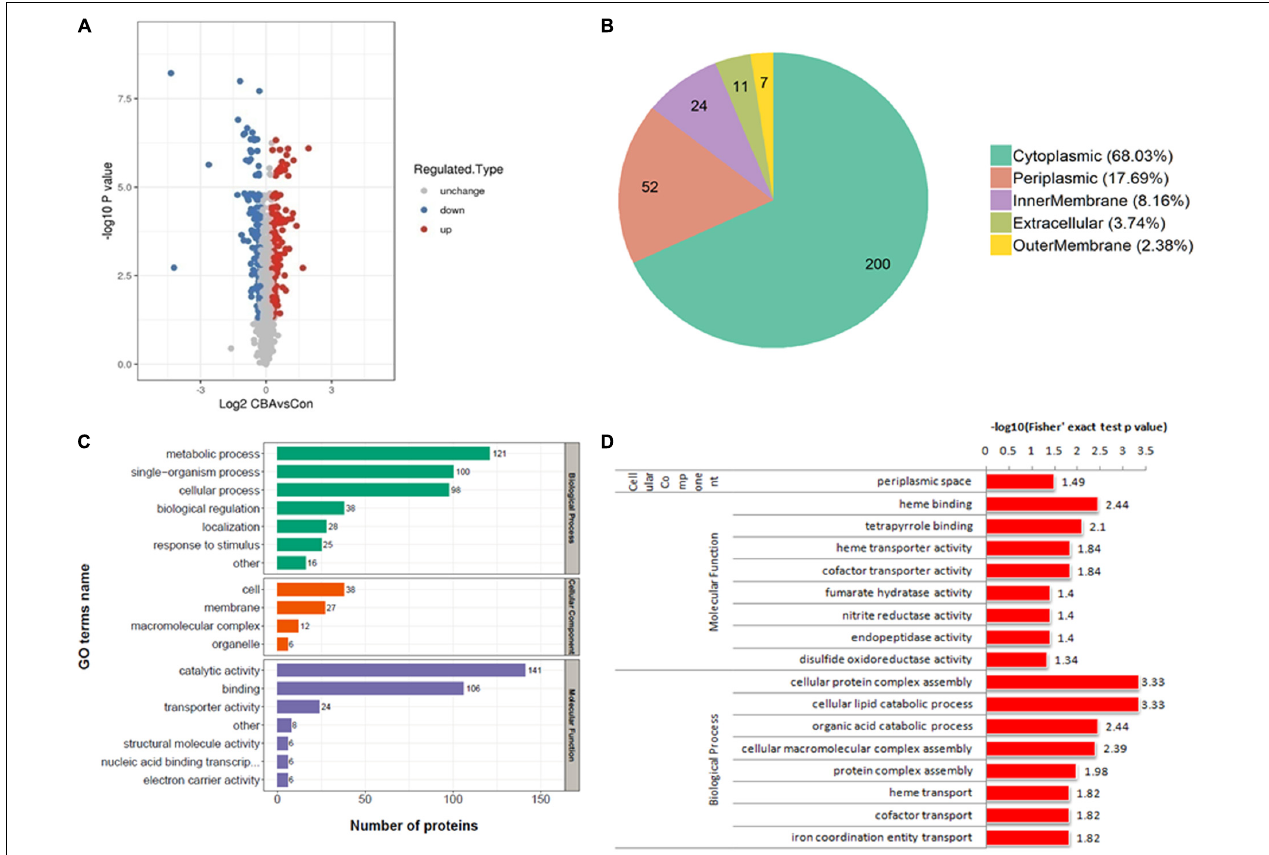
FIGURE 4 | Results of proteomic analysis. The volcano plot shows the upregulated (red) or downregulated (blue) proteins between E. coli-MtrCBA/E. coli-control (A) . Subcellular localization map of the differentially expressed proteins (B) . The differentially expressed proteins classified according to Gene Ontology (GO) annotation (C) . GO enrichment analysis of the differentially expressed proteins (D) . –Log 10 P value represents the negative logarithm of p value calculated by Student’s t -test to base 10. Log 2 CBAvsCon represents the logarithm of the proteins’ difference multiple to the base 2. –Log10 (Fisher’s exact test p value) represents the negative logarithm of p value calculated by the Fisher’s exact test to base